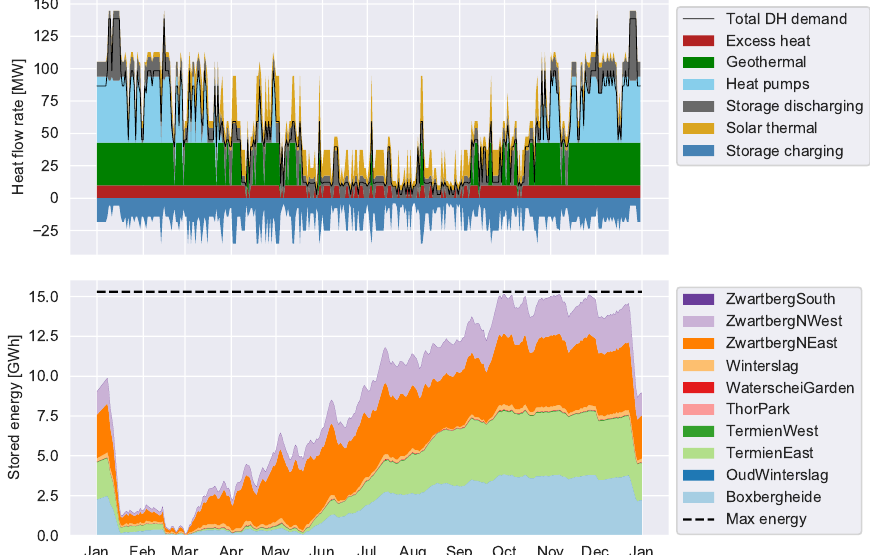
Figure 11. Full year time series for intermediate PEIS design.